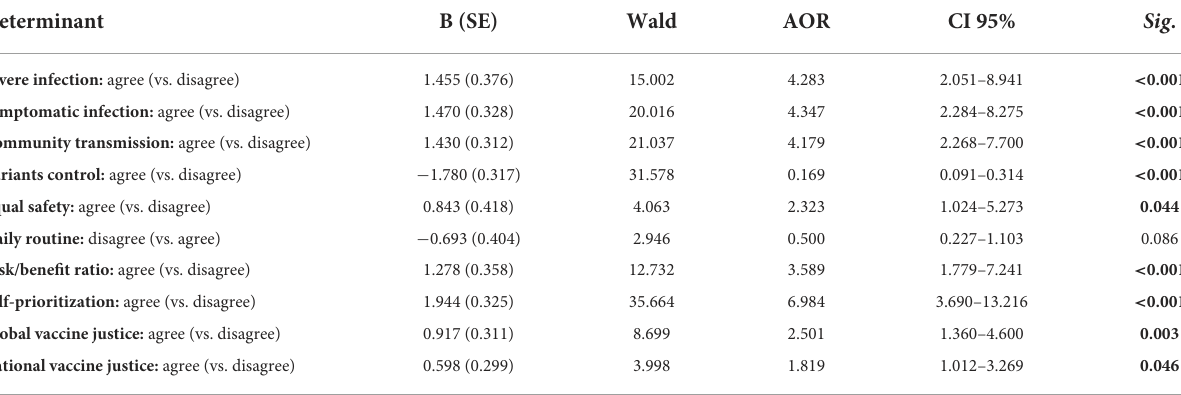
TABLE 9 Psychosocial determinants of COVID-19 vaccine booster uptake among polish healthcare professionals and students responding to COVID-19 VBH survey, December 2021–January 2022 ( n = 443). Determinant B (SE) Wald AOR CI